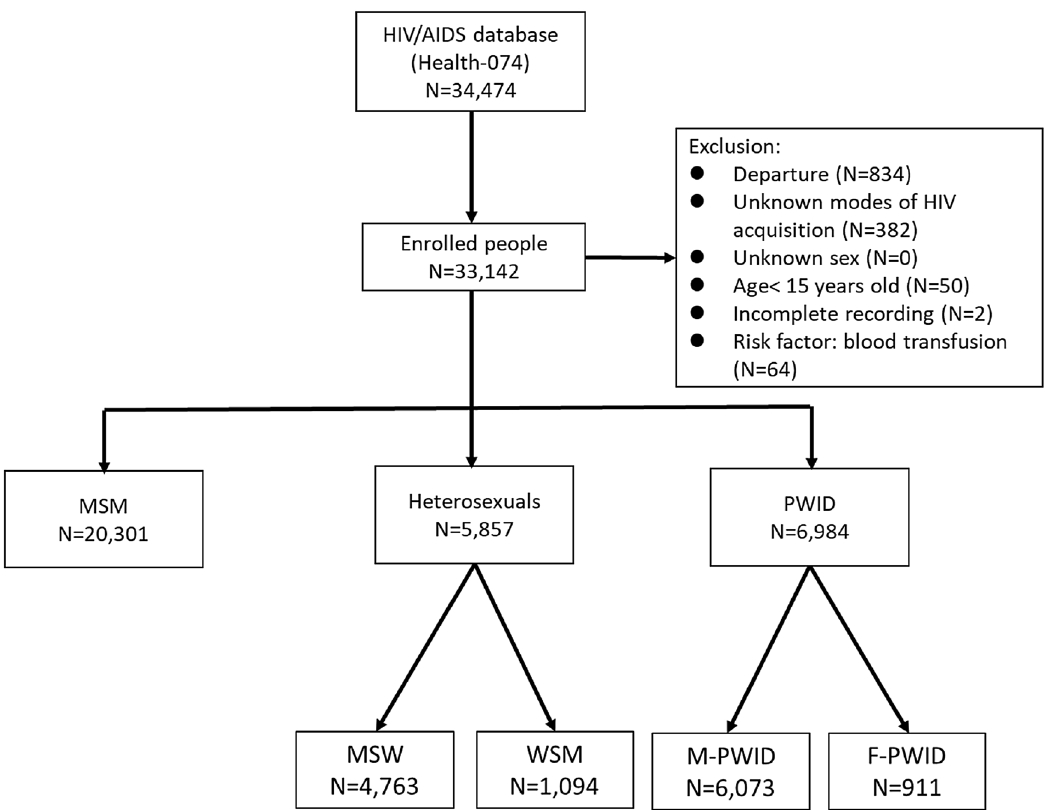
Figure 1. Study flowchart. Abbreviations: AIDS, acquired immunodeficiency syndrome; F-PWID, female persons who inject drugs; HIV, human immunodeficiency virus; PWID, persons who inject drugs; M-PWID, male persons who inject drugs; MSM, men who have sex with men; MSW, men who have sex with women; WSM, women who have sex with